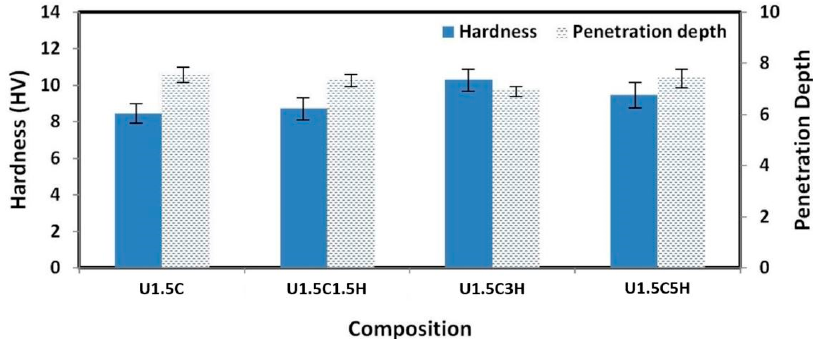
Figure 13. Vickers hardness and penetration depth vs. composition for nanocomposite and hybrid nanocomposite coatings.